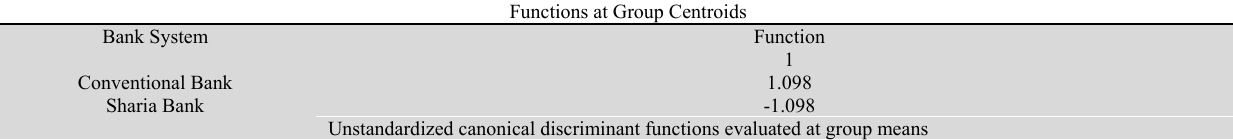
Functions at Group Centroids